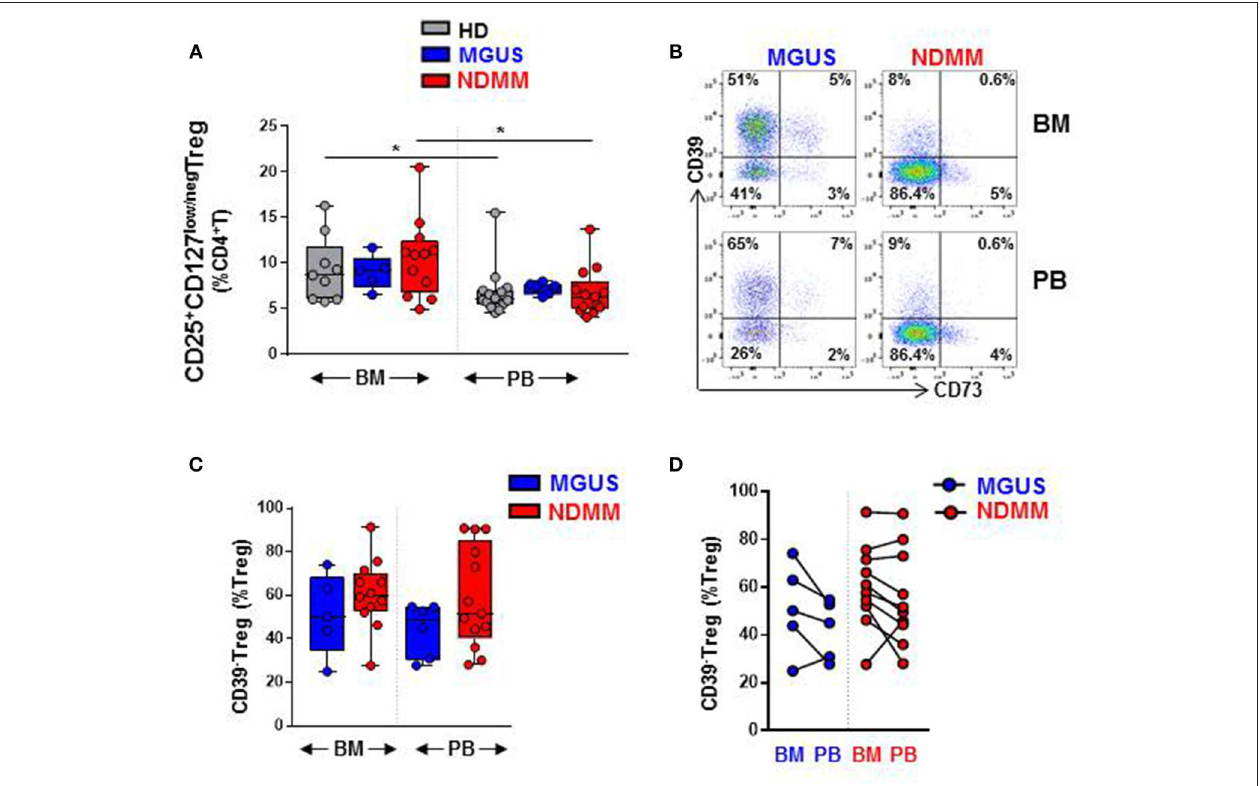
FIGURE 1 | CD39 − Treg are prevalent within the Treg compartment of NDMM patients. Flow cytometry data: (A) Frequency of Treg in BM and PB of HD (BM = 9, PB = 14), MGUS (BM = 5, PB = 6), and NDMM (BM = 12, PB = 13) patients. (B) Representative biaxial plot of CD39 vs. CD73 expression on Treg. Numbers indicate percentage of cells in each quadrant. (C) Frequency of CD39 − Treg within the Treg compartment in BM and PB of MGUS (BM = 5, PB = 6) and NDMM (BM = 12, PB = 13) patients. (D) Frequency of CD39 − Treg in paired BM and PB of MGUS ( n = 5) and NDMM ( n = 10) patients. Box and whisker plots show min and max, with median and individual data points. Multiple independent variables were analyzed using the Kruskal-Wallis test with Dunn’s multiple comparison tests and 2 independent variables with the Mann-Whitney- U -test and Wilcoxon matched-pairs signed rank test; * p <